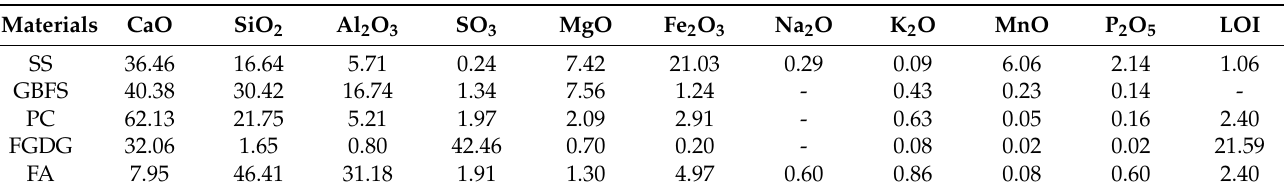
Table 1. Chemical composition of raw materials (wt.